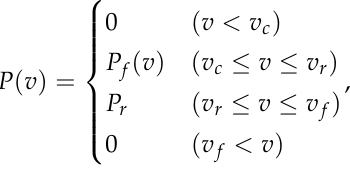
Figure 1. Four regions of the wind turbine power curve.